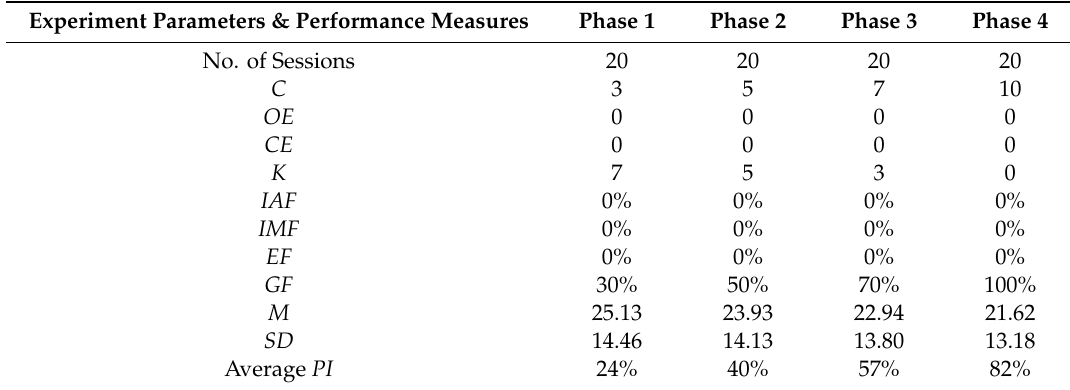
Table 2. Summary of statistical data obtained during the second part of the experiment. Experiment Parameters & Performance Measures